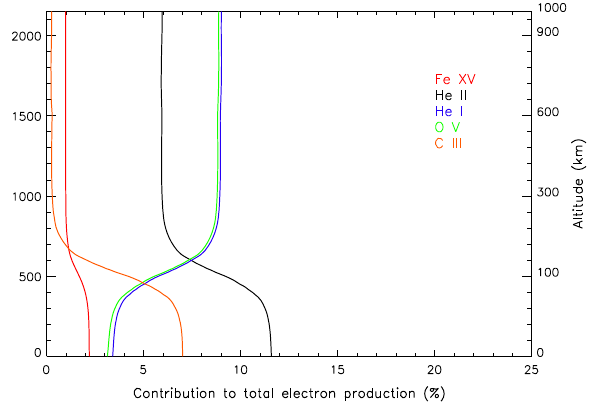
Fig. 4. Contribution to the electron production for five solar lines. Fig. 5. Contribution to the red line emission from Lyman a